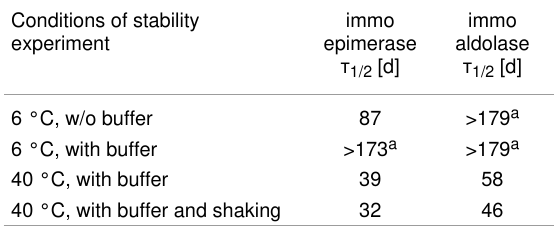
Table 2: Storage, temperature, and mechanic stability of immobilized epimerase and aldolase. a Conditions of stability